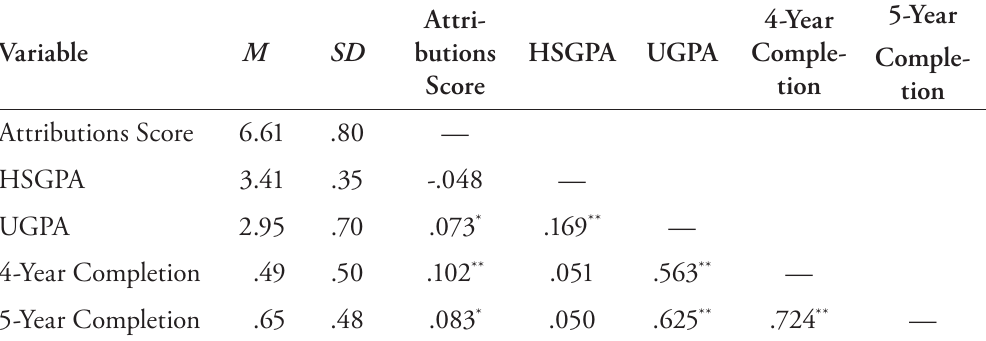
Table 3. Means, Standard Deviations, and Intercorrelations between the Study Variables